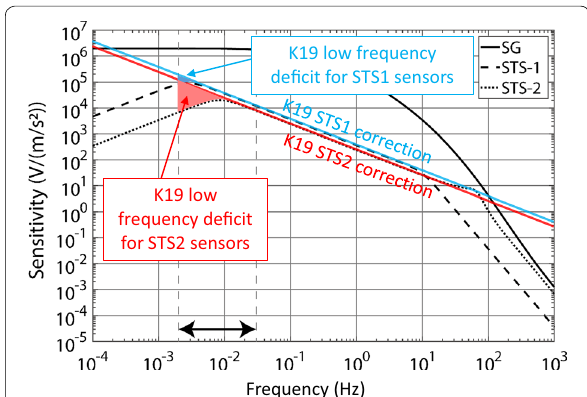
Fig. 1 Low‑frequency deficit induced by the instrument correction made by K19. Black lines show how an acceleration signal with flat spectrum is recorded by several sensors as a function of frequency (modified from Fig. S1 of K19). The V17 correction uses the complete instrument response of the STS1 and STS2 sensors (dashed and dotted lines, respectively) while the K19 correction uses a frequency‑independent counts‑to‑velocity conversion factor (blue and red lines, respectively. The blue and red areas (for STS1 and STS2, respectively) highlight the difference between the two procedures in the analyzed frequency range, 0.002–0.03